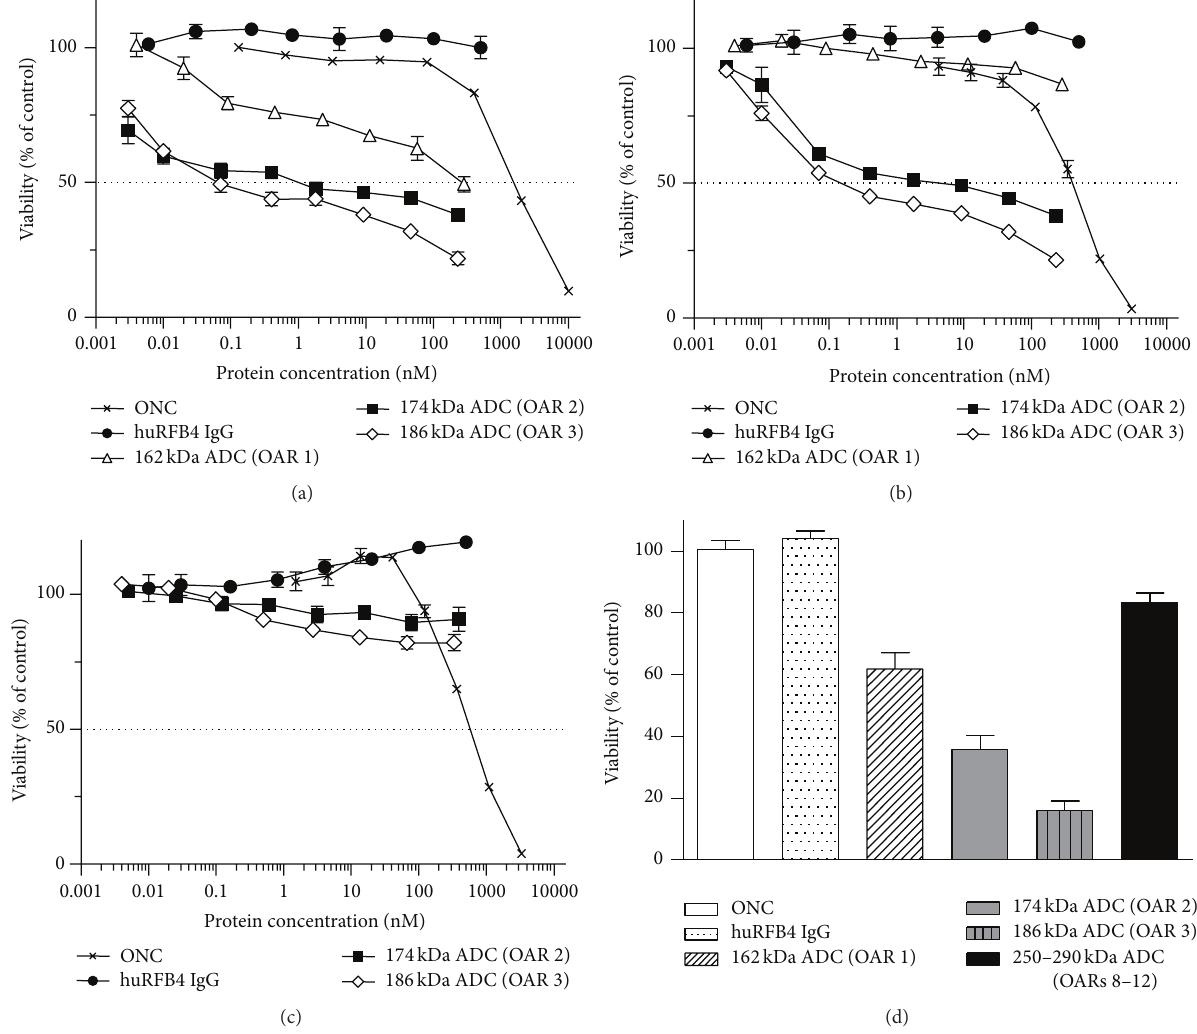
Figure 5: Dose- and DAR-dependent in vitro cytotoxicity of SPDP-based ADCs. CD22-positive Daudi (a), Nalm6 (b), and CD22-negative Jurkat (c) cells were incubated with varying concentrations of SPDP-based ADCs with distinct OARs. ONC and huRFB4 IgG were used as positive and negative control, respectively. Cell viability was determined after 72 h and is expressed relative to buffer-treated control cells. (d) Cytotoxic activities towards Daudi cells of immunoconjugates with low OAR were compared to antibody-ONC populations with higher ONC loading (OARs 8–12) at equal molar doses of 10nM each. As immunoconjugate species with eight to twelve ONC payloads could not be further separated, molar calculations for the 250–290 kDa ADC were averaged for a payload of 10 RNases. Data depict the mean value ± SE from one representative experiment performed in